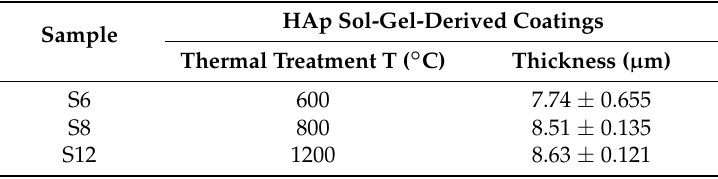
Table 2. Thickness measurements of HAp sol-gel-derived coatings treated at different temperatures.